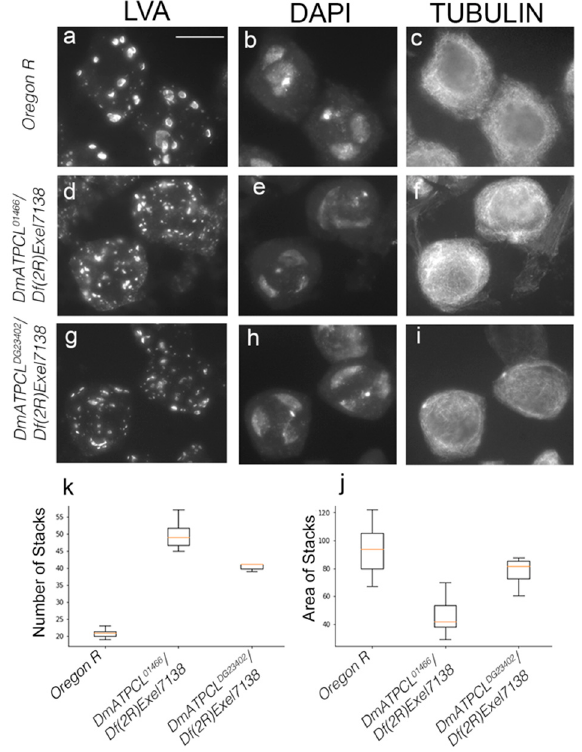
Figure 3. Depletion of DmATPCL affects the Golgi apparatuses in primary spermatocytes. ( a ) Primary spermatocytes from wild-type Oregon R ( a – c ) and mutant ( d – i ) testes stained for Lava (Lva; a , d , g ), DAPI ( b , e , h ) and tubulin ( c , f , i ). Note that the Golgi stacks organization, as revealed by the anti-Lva immunostaining, is altered in DmATPCL mutant hemizygous combinations. Tubulin staining indicates that all primary spermatocytes are at the same developmental stage (S4–S5) [11]. ( b ) Box plots showing the quantification of number and extension of Lva-positive Golgi structures from 20 wild-type and mutant primary spermatocytes. See text for further details ( p < 0.05, t-Student Test). Scale bar = 10 µm.